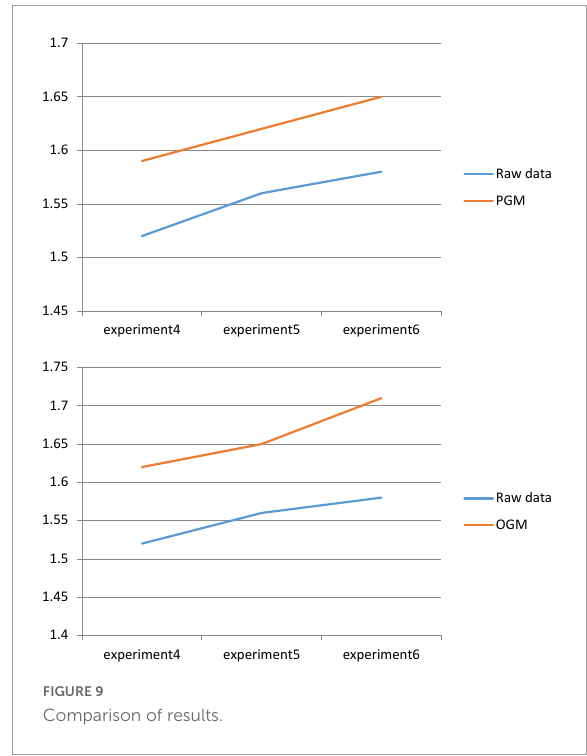
FIGURE9 Comparison of results.